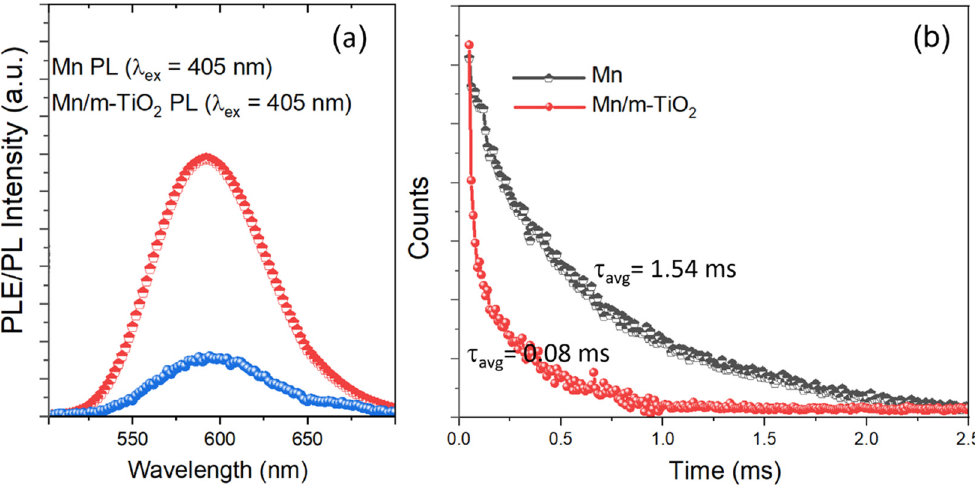
Figure 5: ( a ) PLE/PL spectra and ( b ) PL decay curves of CsPb 1 – x Mn x Br 3 – 2 x Cl 2 x ( x = 0 – 0.5 )